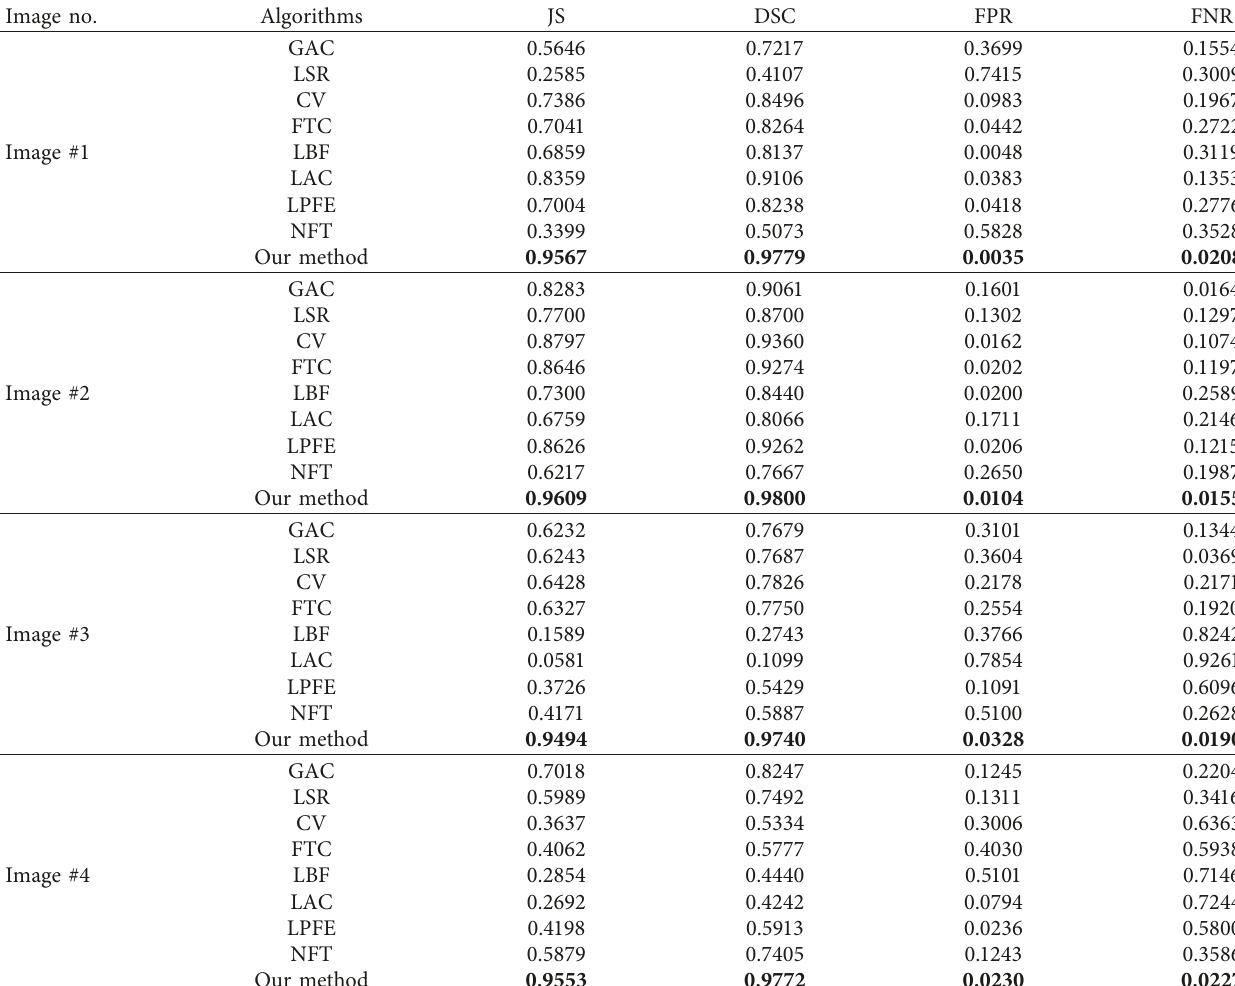
Table 2: Region overlap metrics of different algorithms corresponding to Figure 5 in the same order. Image